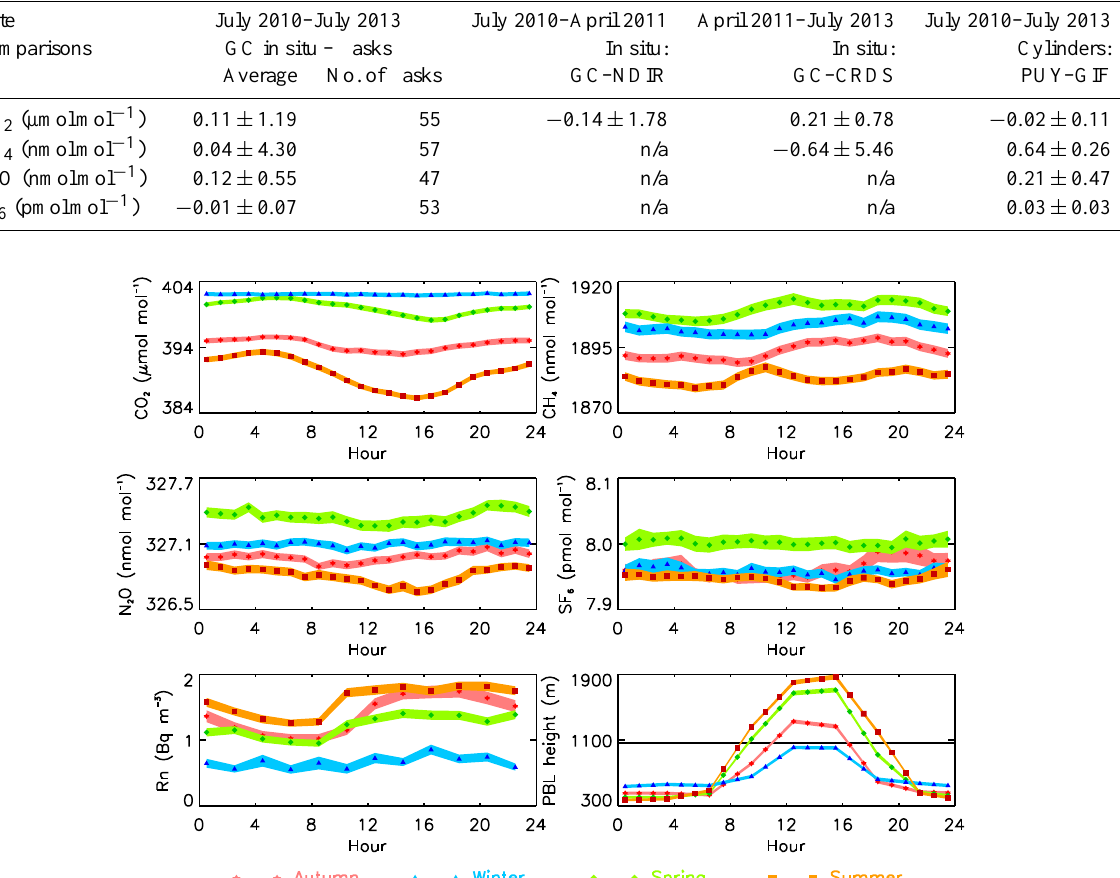
Figure 6. Mean diurnal cycles of CO 2 , CH 4 , N 2 O, SF 6 , and 222 Rn together with the planetary boundary layer height (relative to Clermont- Ferrand altitude – 396ma . s . l . ) at the Puy de Dôme station for each season. Trace gas mole fractions were detrended based on 1 January 2013.